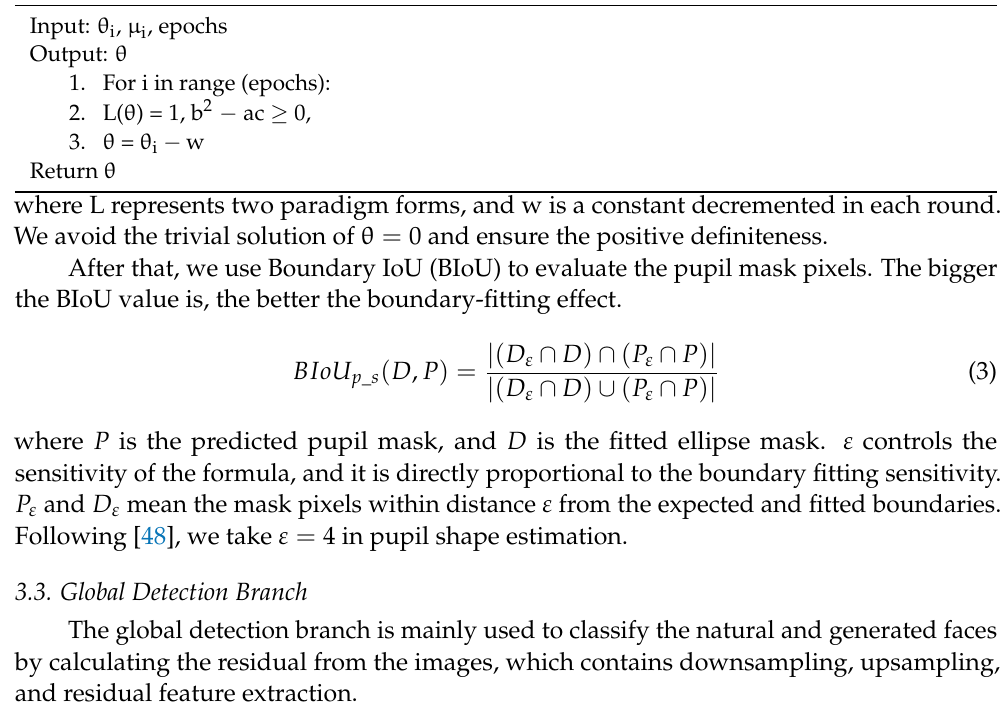
Algorithm 1 Pseudo-code of